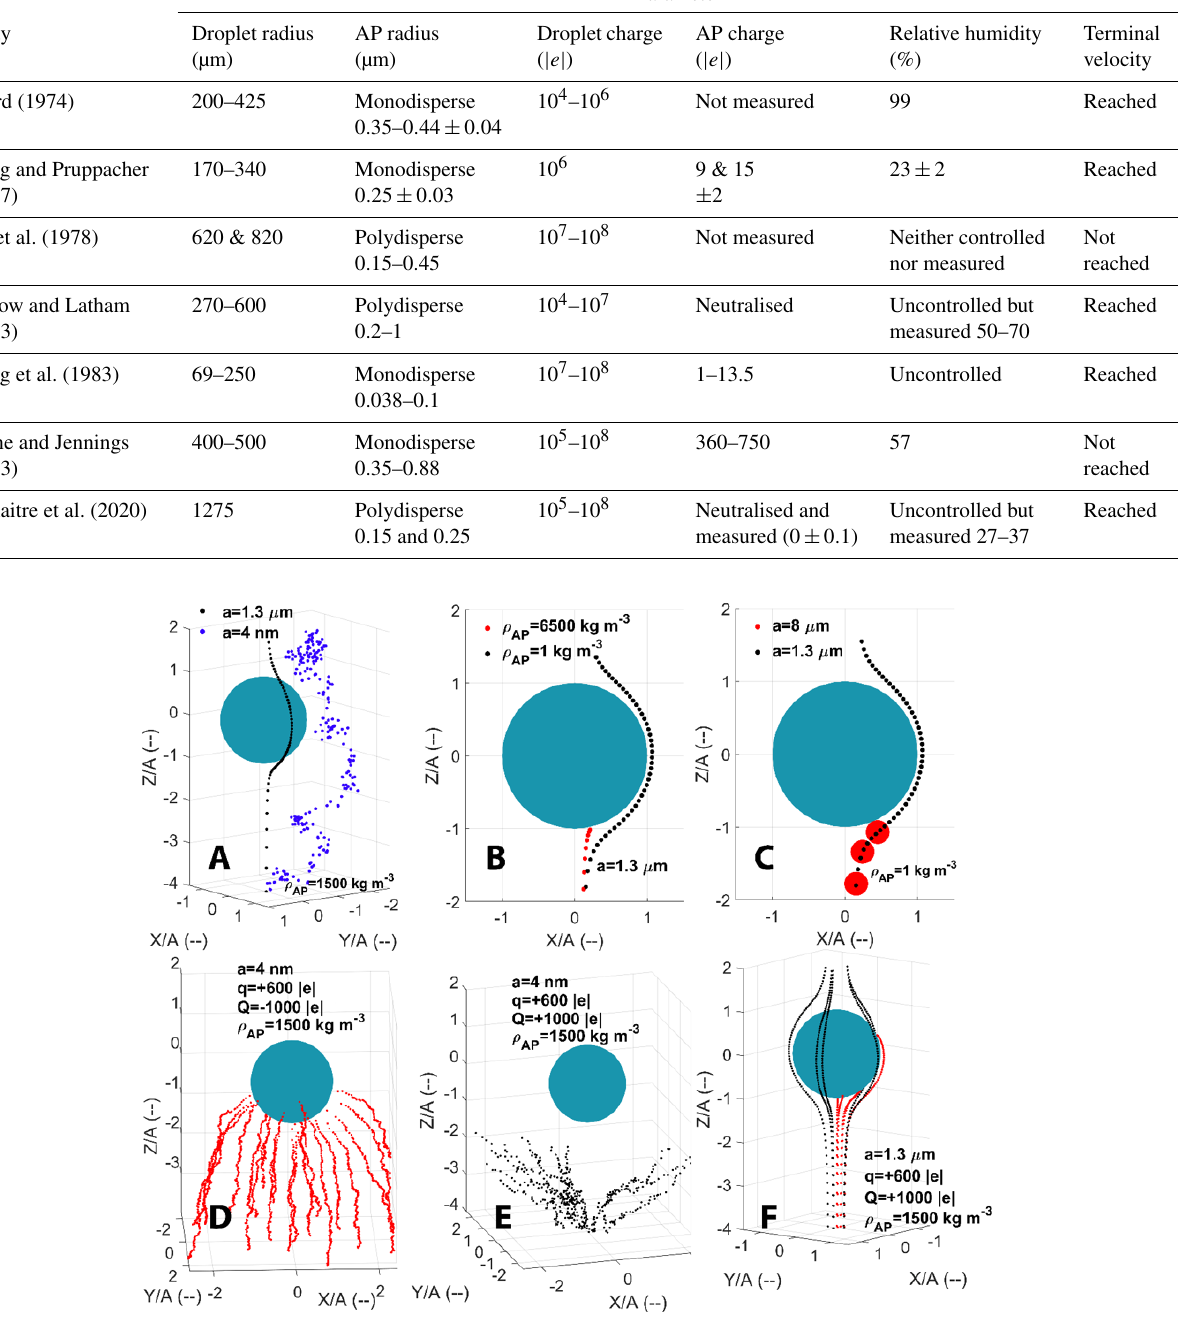
Figure 1. AP trajectories computed with the extended Dépée et al. (2019) model for a 50µm droplet radius ( A ) and AP with various radii ( a ) and densities ( ρ AP ). The air temperature ( T air ) and the air pressure ( P air ) are − 17 ◦ C and 540hPa, respectively. The panels indicate the effects of Brownian motion (a) , inertial impact (b) , interception (c) , and electrostatic forces with attractive (d) and repulsive (e, f) Coulomb forces. Red trajectories result in an AP collection. The droplet ( Q ) and AP ( q ) charges are labelled. Panels (b) to (f) – the red trajectories result in an AP collection. Adapted from Part I (Dépée et al.,